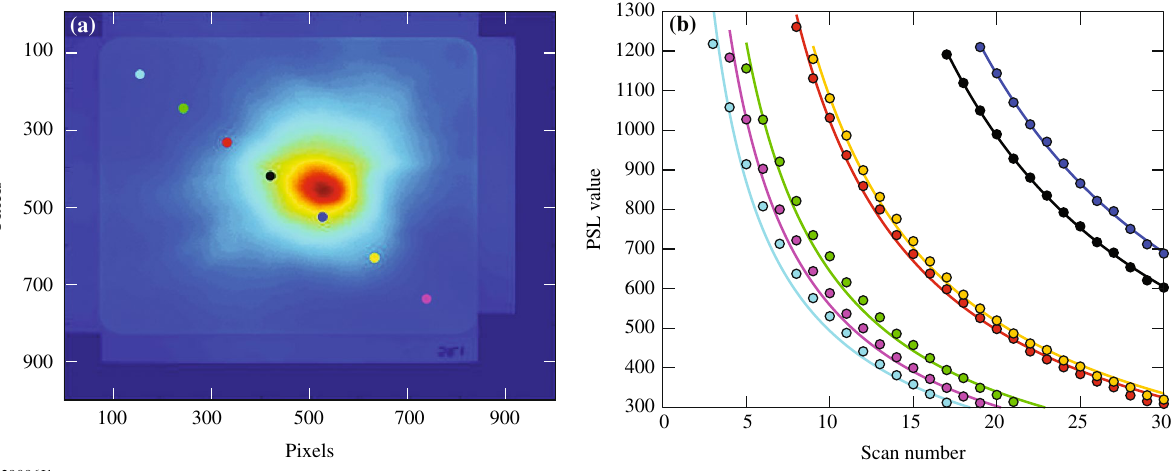
Figure 6. ( a ) Front image plate after being scanned 30 times to remove all saturation in the readout. Colored points mark the seven locations where the decay of the PSL value with scan number is recorded. ( b ) PSL values versus scan number at the seven locations. Colors of the curves correspond to the colors of the points in ( a ) across the image plate. Solid lines are the power fits to each